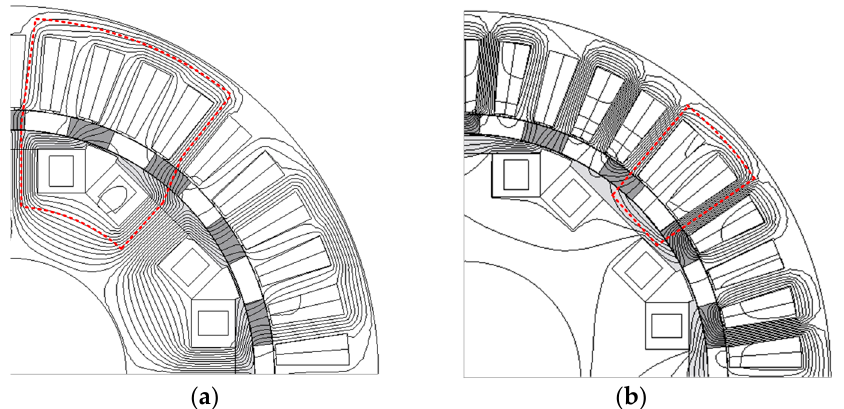
Figure 2. Magnetic-flux path of the proposed machine: ( a ) field-excitation magnetic-field and ( b ) armature-reaction magnetic-field.